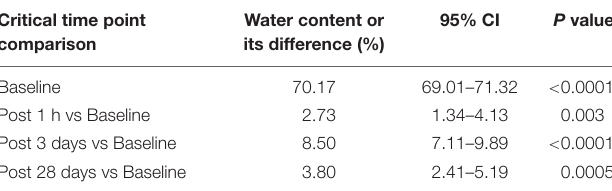
TABLE 1 | Water content comparisons at the four critical